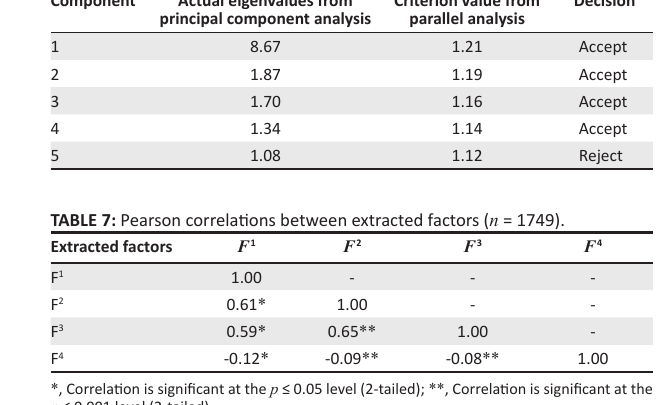
TABLE 6: Results of the Monte Carlo parallel analysis. TABLE 5: Eigenvalues >1 and explanation of variance.